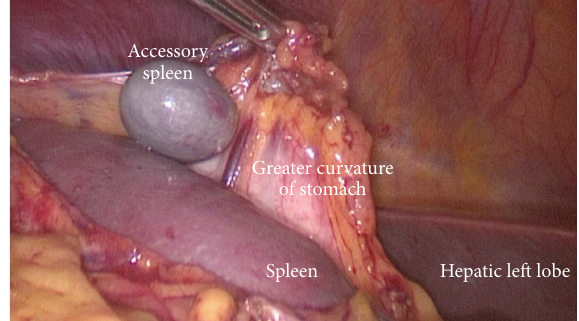
Figure 3: Intraoperative view; accessory